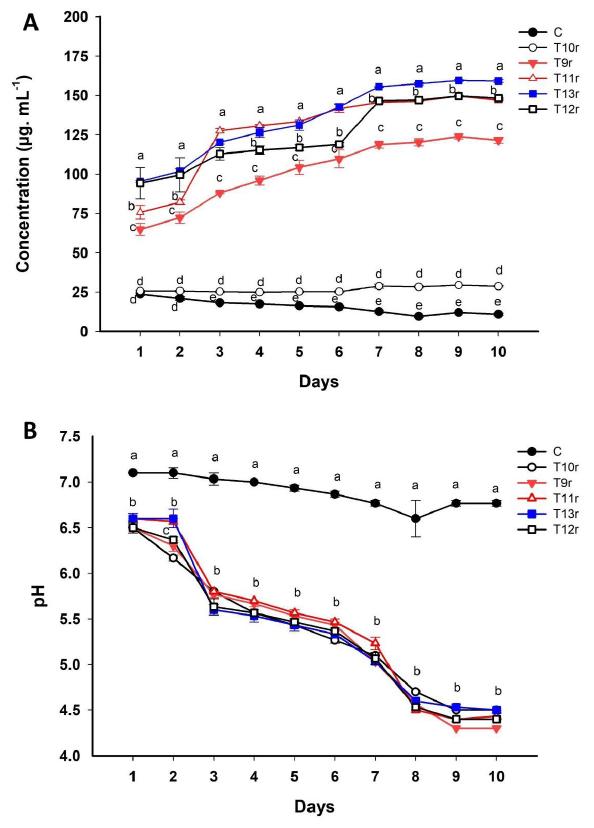
Figure 2: Quantitative phosphate solubilizing assay in Pikovskaya’s broth medium supplemented with Ca of liberated phosphorus (µg ml –1 ) at interval times; B is denotes the pH values of Pikovskaya’s media at interval times. Values within the same time interval with different letters are significantly different ( p ≤ 0.05), values are means ± SE ( n =